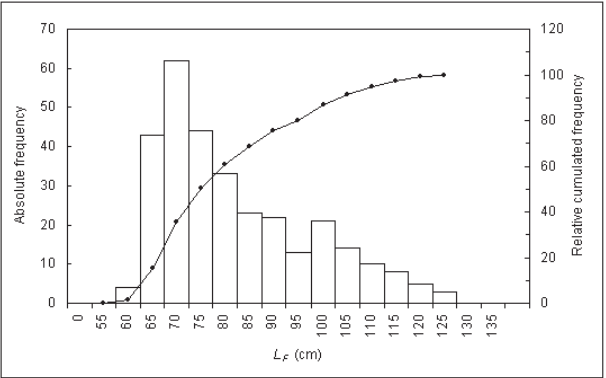
Fig. 3 . Size distribution of absolute frequency (columns) and relative cumulated frequency (line) for black grouper Mycteroperca bonaci caught in North area.